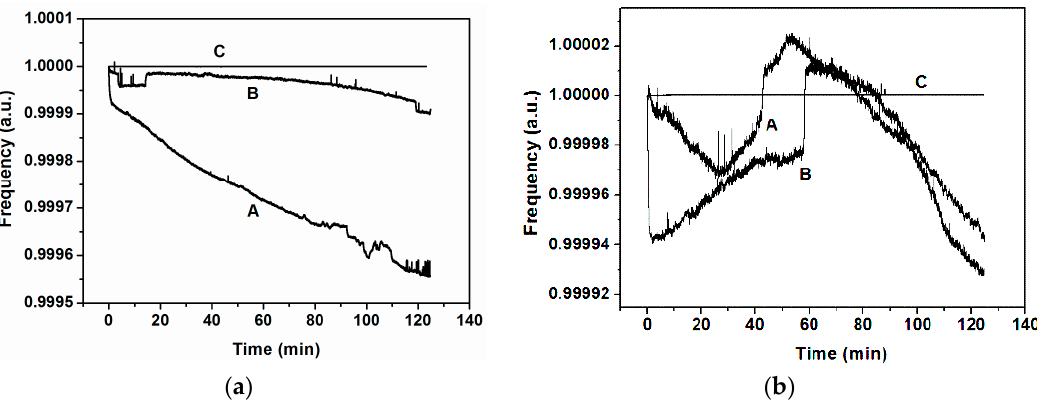
Figure 7. ( a ) Closed-loop frequency scaled at the starting point for the case of stimulus at cantilever number 2 with different frequencies: A , at 1.06 MHz; B , at 1.04 MHz; C , at 1.0549 MHz; ( b ) Closed-loop frequency scaled at the starting point for the case of stimulus at cantilever number 4 with different frequencies: A , at 1.08 MHz; B , at 1.06 MHz; C , at 1.07348 MHz.